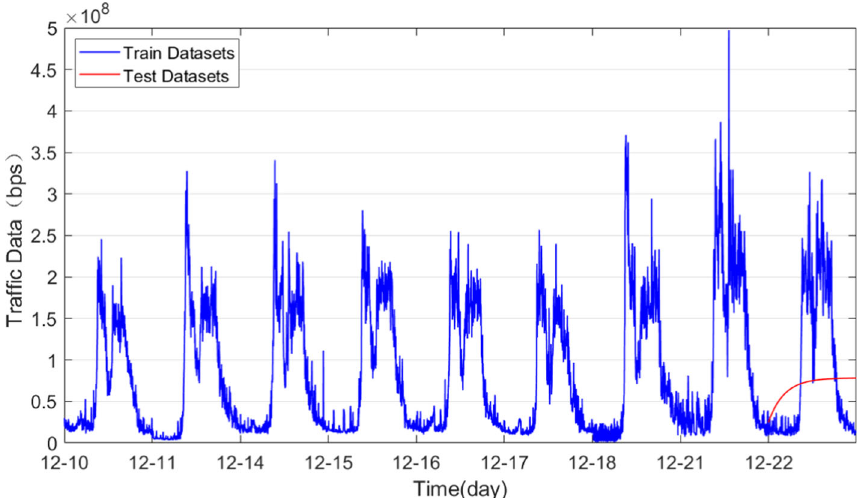
Fig. 8 Linear prediction based on ARIMA